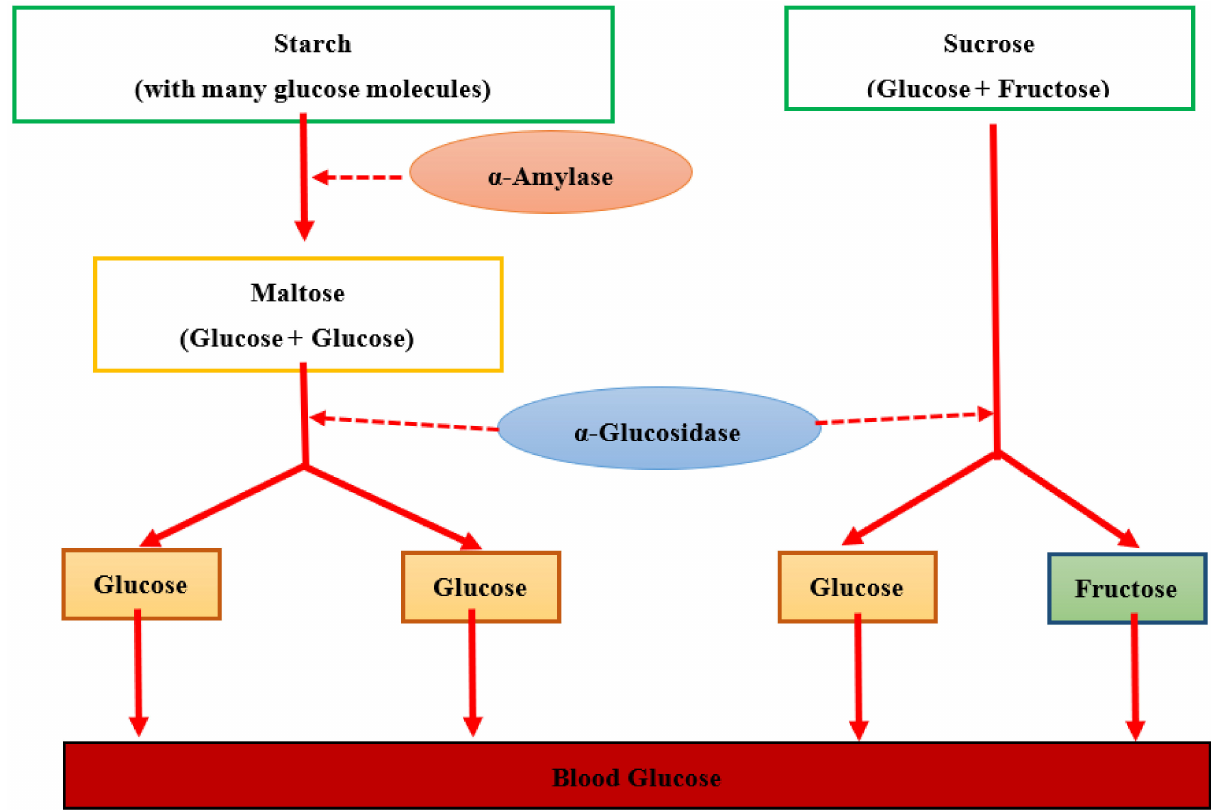
Figure 1. Hydrolysis of starch to glucose as catalyzed by α -amylase and α -glucosidase (adapted from